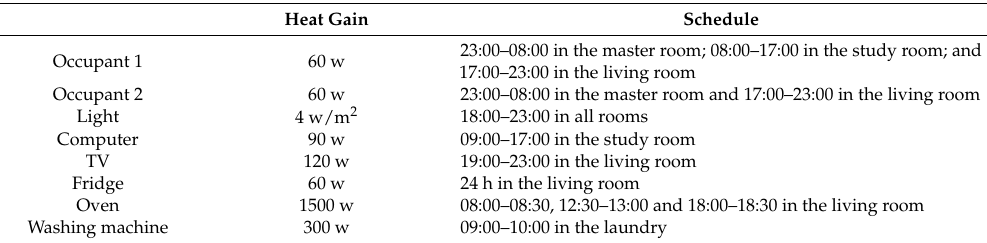
Table A2. Occupant activity and equipment usage.